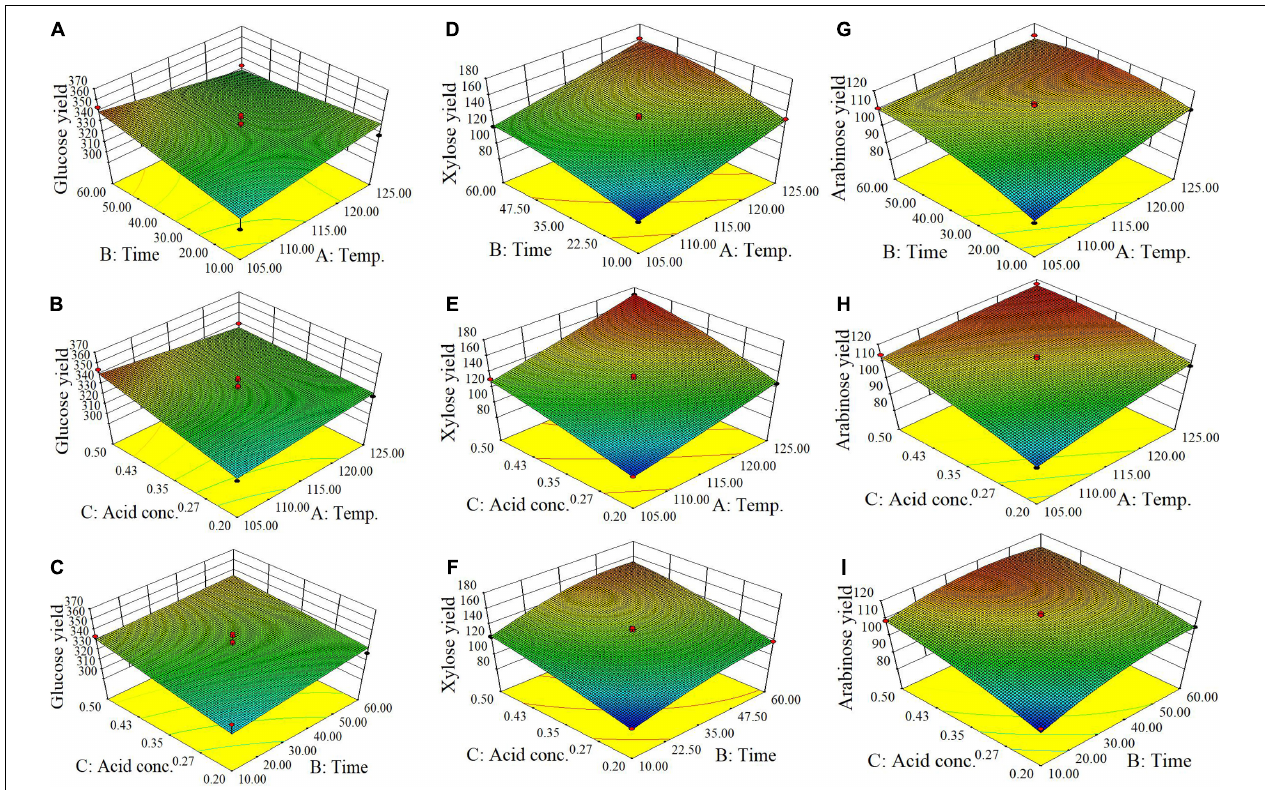
FIGURE 1 | Response surface plots of yields of glucose (A–C) , xylose (D–F) , and arabinose (G–I) (mg/g corn fiber) obtained from the Box-Behnken design of